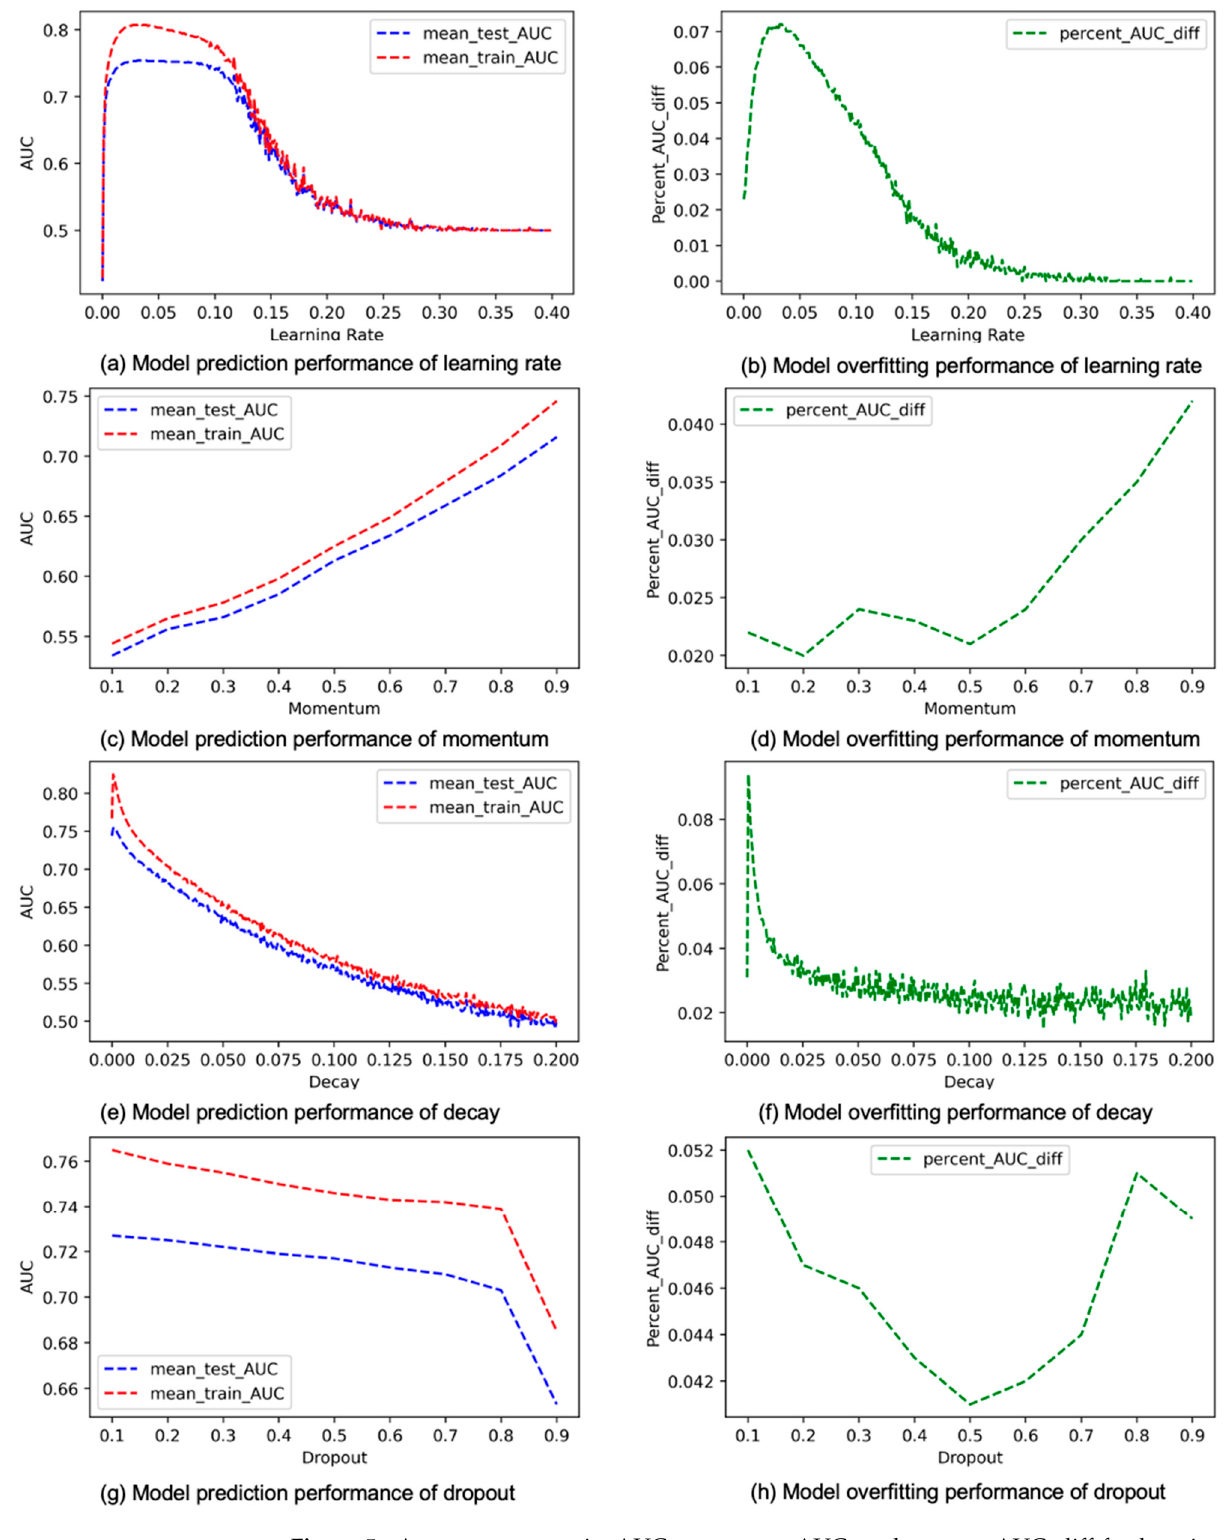
Figure 5. Average mean_train_AUC, mean_test_AUC, and percent_AUC_diff for learning rate, momentum, decay, and dropout.